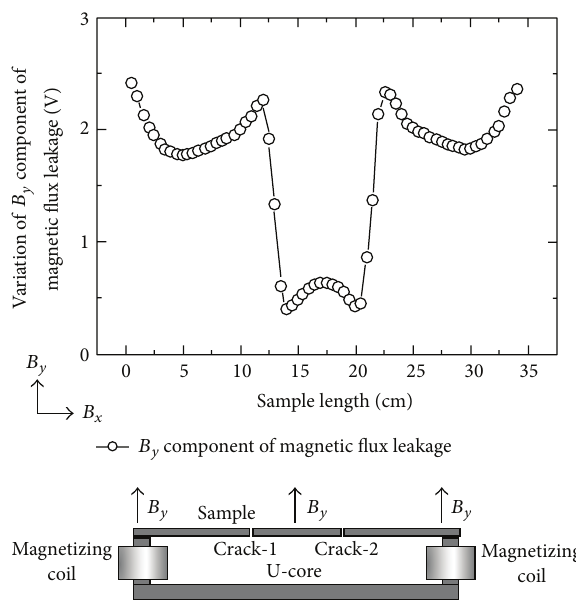
Figure 9: Measurement of 𝐵 𝑦 component of the magnetic flux leakage with sample between core legs with two cracks.